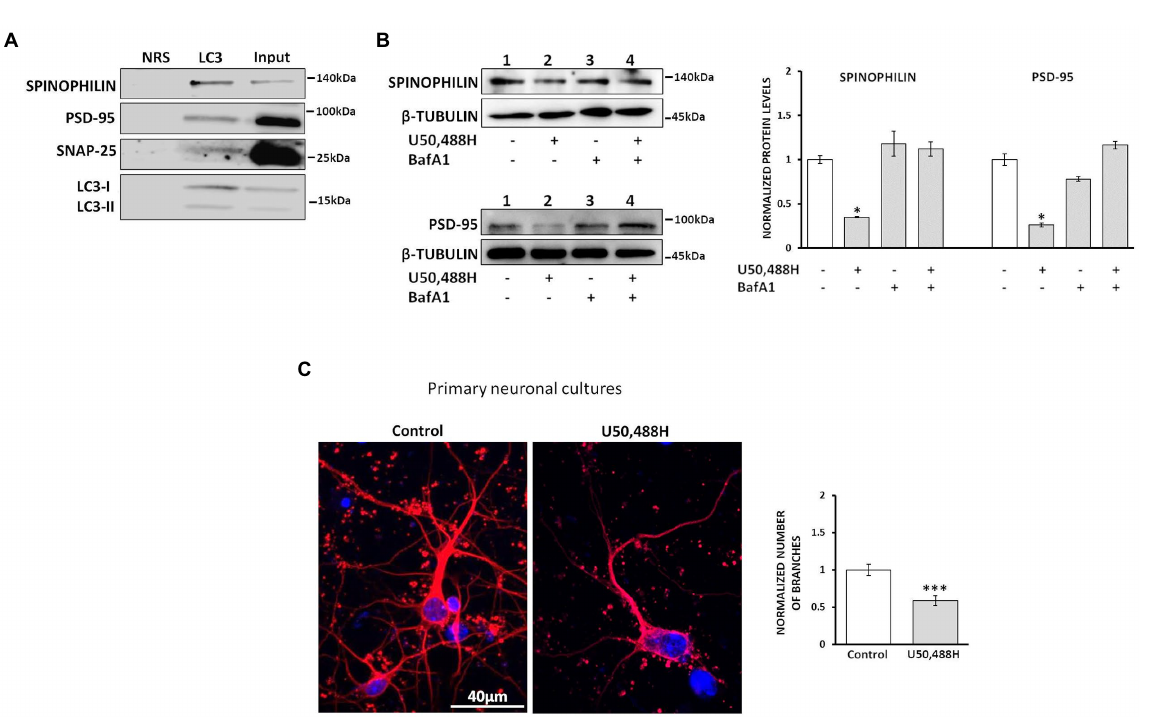
FIGURE 6 κ - Ο R-mediated autophagy leads to degradation of synaptosomal proteins. (A) Hippocampal lysates (800 μ g) were immunoprecipitated with 2 μ g of an LC3B antibody and immunoblotted with spinophilin, PSD-95, and SNAP25. NRS immunoprecipitated samples were used as negative control. The experiment was performed 3 times. (B) κ -Neuro-2A cells were pre-treated with 20 nM BafA1 for 24 h, following exposure with 20 μΜ U50,488H for 16 h. Cell lysates were subjected to 10% SDS-PAGE and the protein levels of spinophilin, PSD-95 and SNAP25 were detected using the corresponding antibodies. Quantification of the synaptic proteins was normalized using β -tubulin. Error bars represent mean values ± SEM of three independent experiments. Statistical analysis was performed using one-way ANOVA, * p < 0.05 as compared with the values in the absence of agonist. (C) Primary hippocampal neuronal cultures were treated for 24 h with 20 μΜ U50,488H and labeled with a Tuj1 antibody (1:1000). Nuclei were stained with TO-PRO-3 (blue) (1:500). Graph represents mean ± SEM of the number of branches calculated from 100 Tuj1-positive neurons of U50,488H-treated neurons normalized to control ones set as 1; scale bar: 40 μ M. Statistical analysis was performed using one-way ANOVA, *** p < 0.001 as compared with the untreated